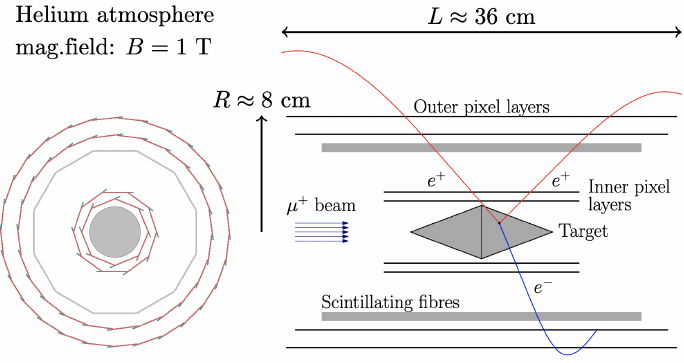
Figure 15. Schematic of the Mu3e experiment (Figure from